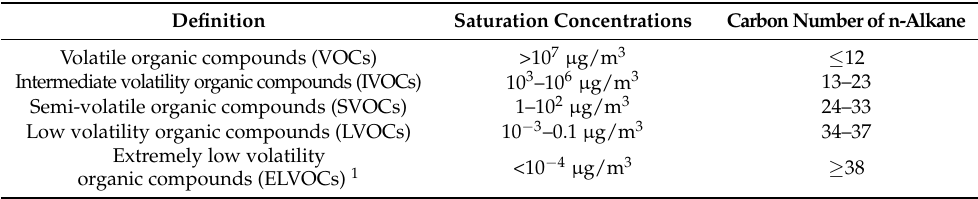
Table 1. Classification of organic compounds based on their saturation concentration and examples of representative alkanes at each class [27,29,30].